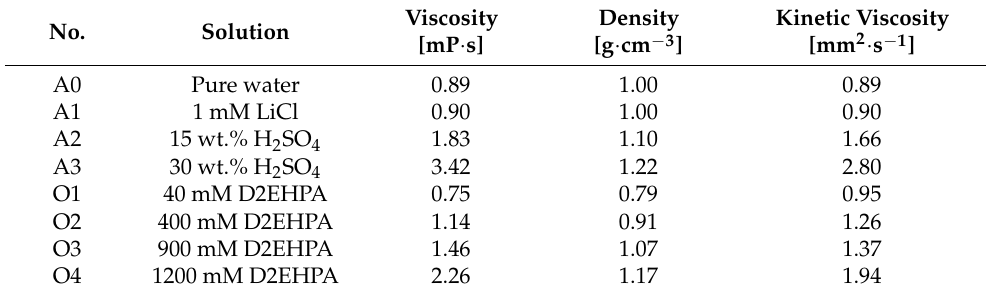
Table 1. Viscosity and kinematic viscosity of the solutions used in this experiment. No.